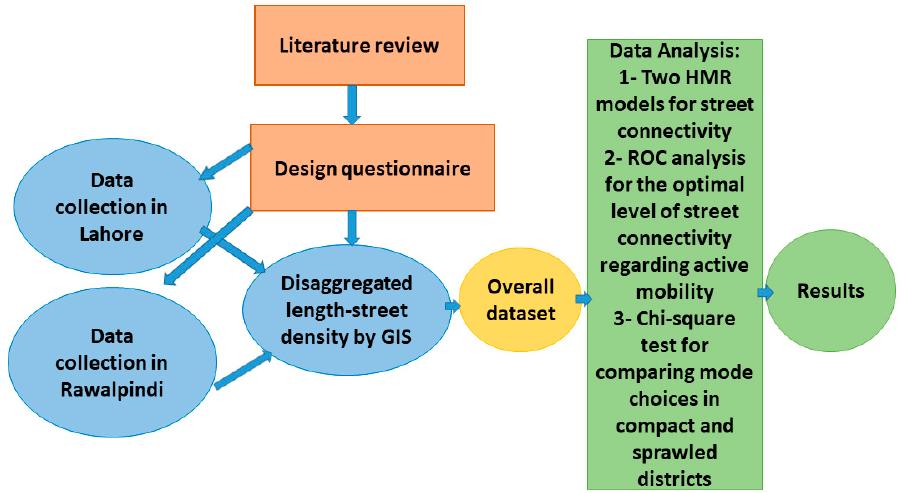
Figure 1. The flow chart of the steps of the methodology.